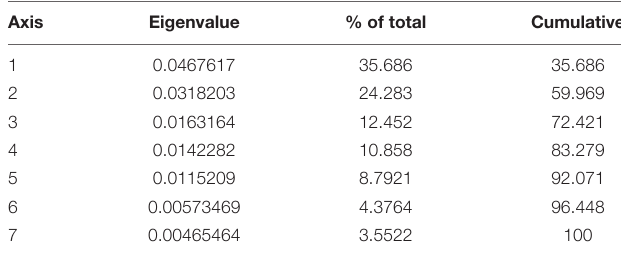
TABLE 2 | Correspondence analyses axes, eigenvalues and percent variation values for the sample comprising the extinct artiodactyl taxa from North America and the Serengeti fauna (excluding modern day